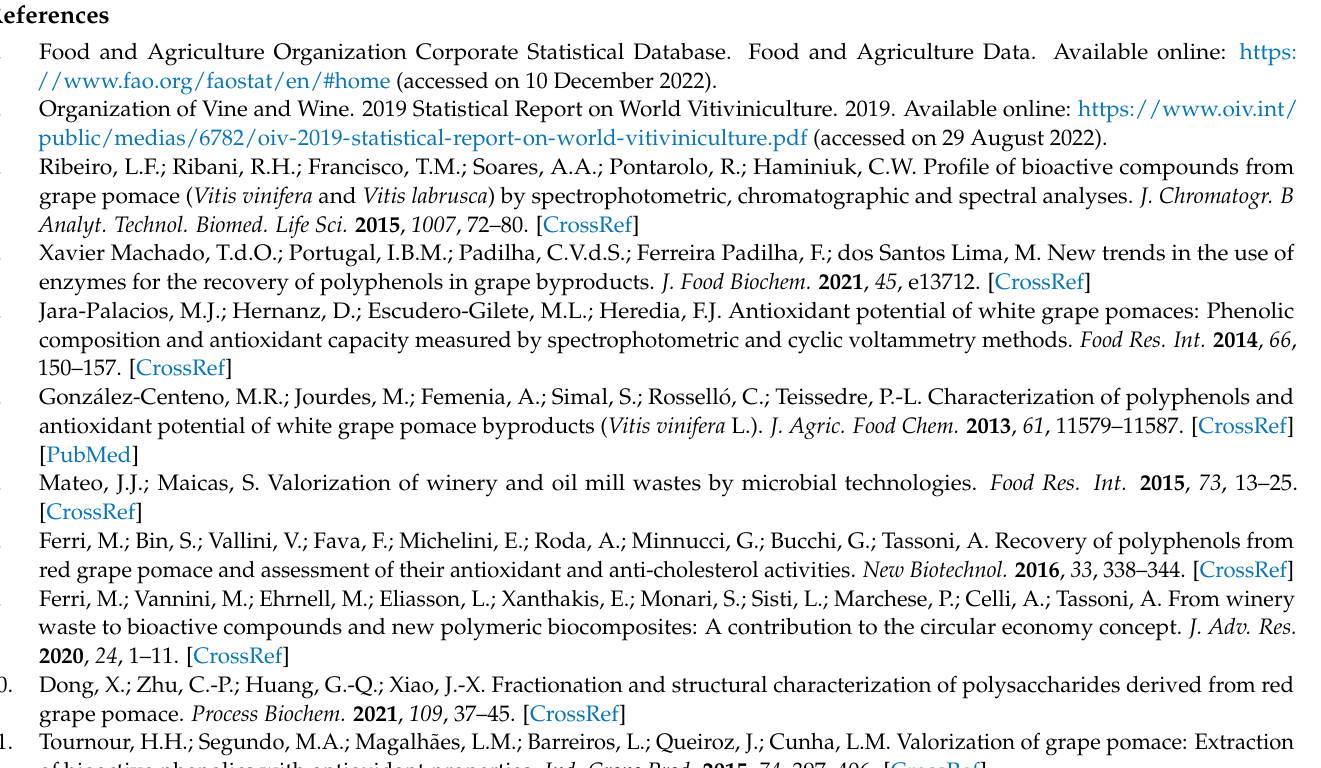
treatment. Figure S2: Response surface and semiamplitude of the 95% confidence interval for the Merlot red GP and the white Garganega GP models for Celluclast treatment. Figure S3: Response surface and semiamplitude of the 95% confidence interval for the Merlot red GP and the white Garganega GP models for Driselase treatment. Figure S4: Response surface and semiamplitude of the 95% confidence interval for the Merlot red GP and the white Garganega GP models for Viscozyme